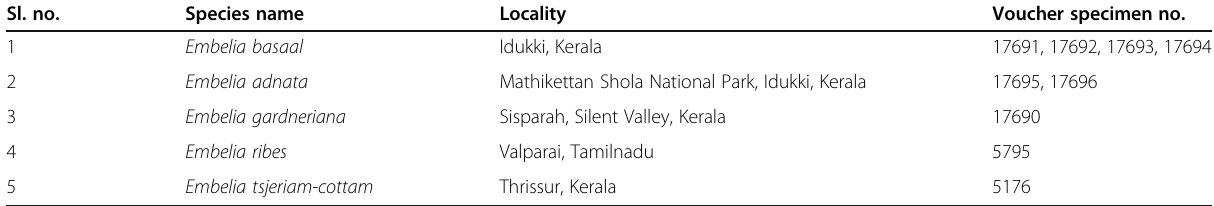
Table 1 Collection details of different species of Embelia Sl.